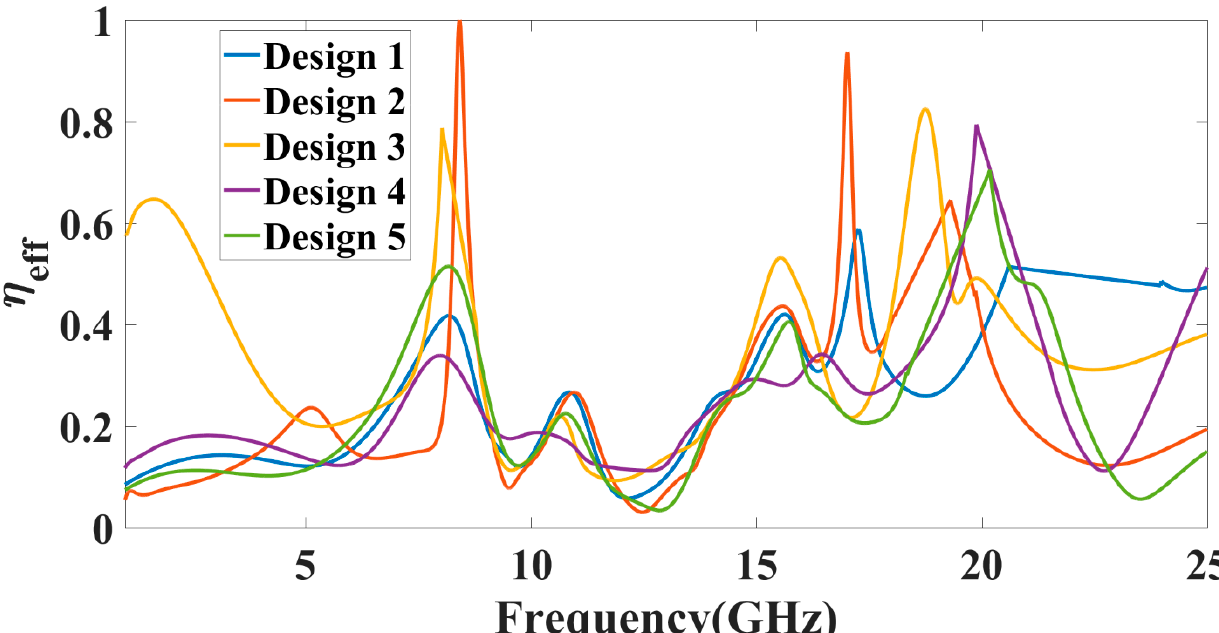
Figure 7. Variation in antenna radiation efficiency for different designs of antenna.